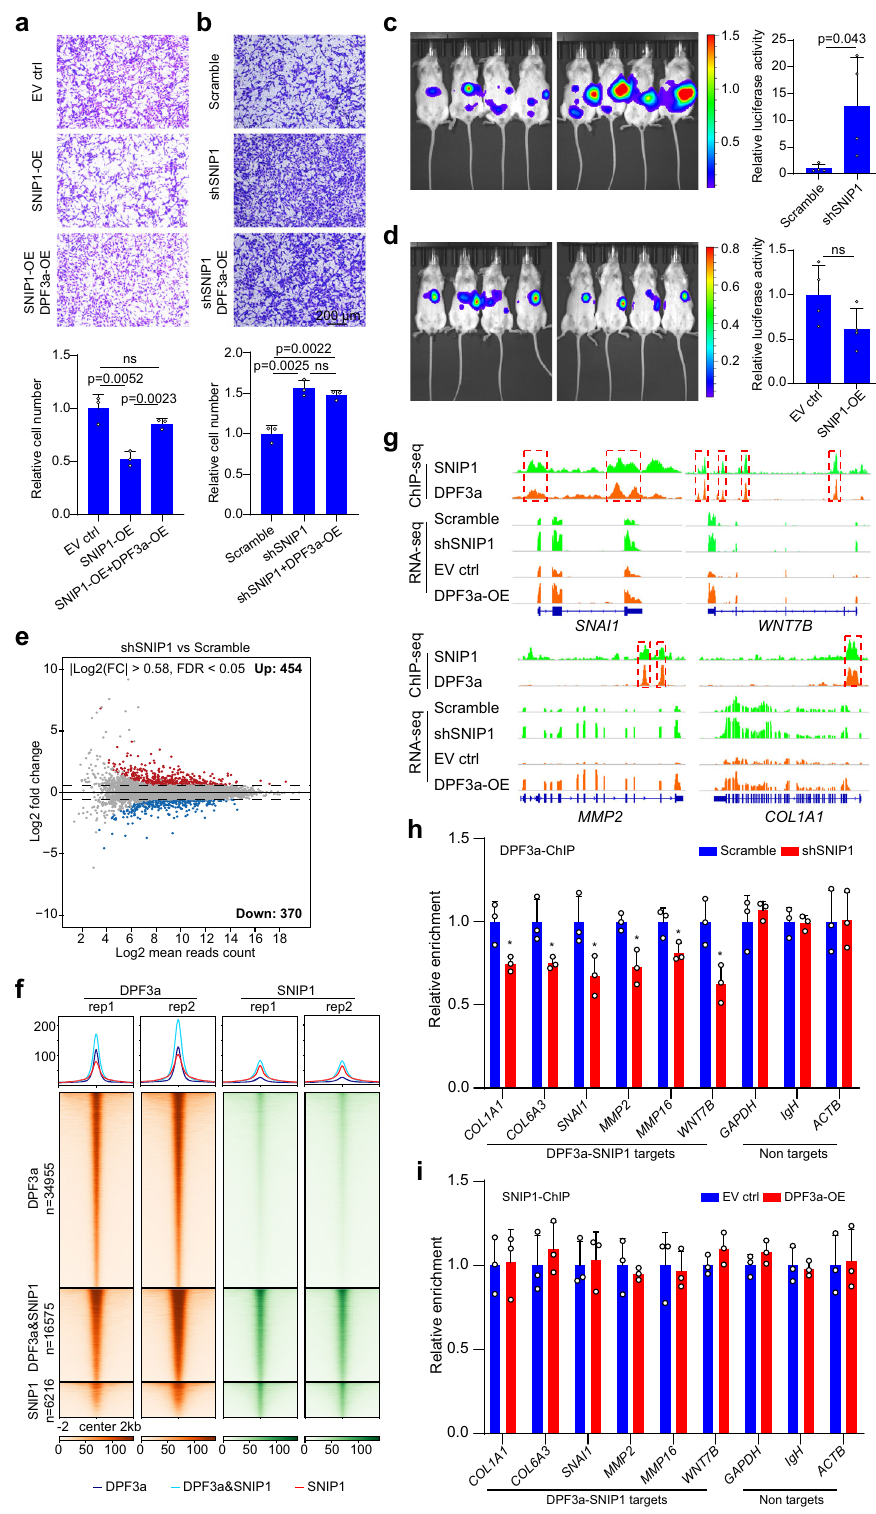
DPF3a binding released the inhibitory effect of SNIP1 on p300